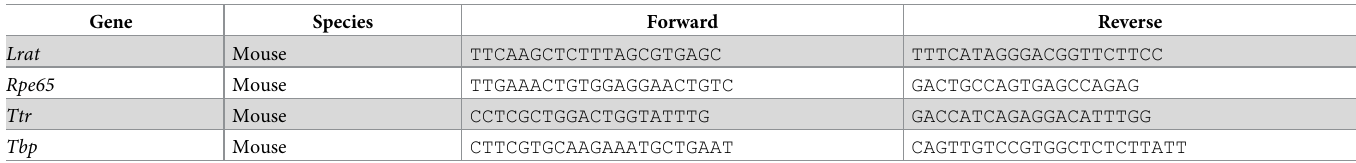
Table 1. Primers used for qRT-PCR.